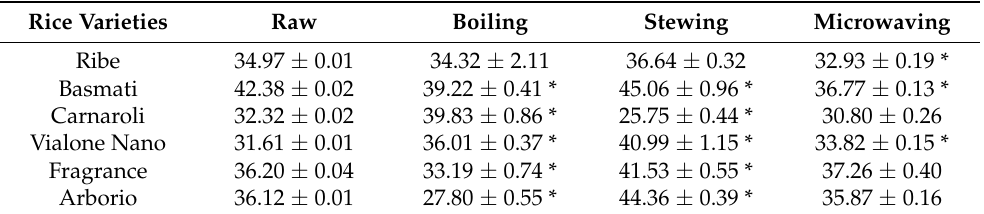
Table 6. Amylose percentage respect to total carbohydrates in raw rice and after the three cooking methods